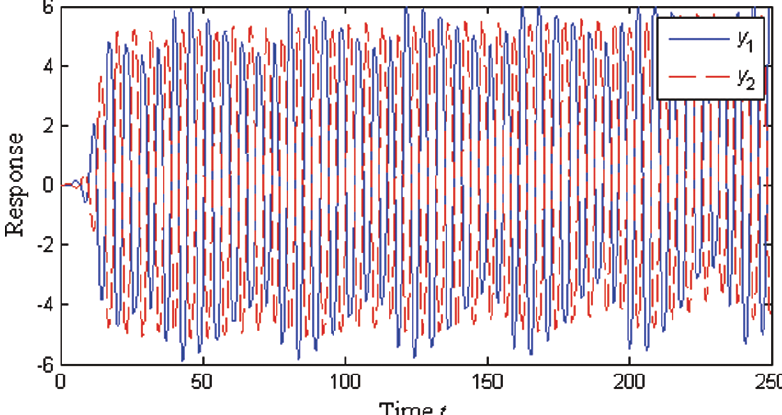
Fig. 13. Time history with feedback control with assumed parameters.